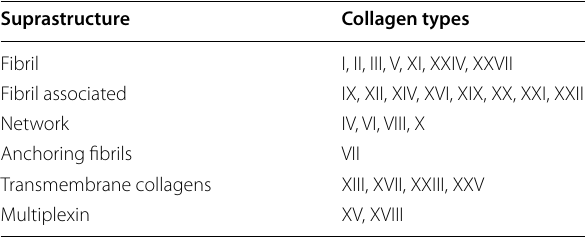
Table 2 Different collagen types organized in various suprastructures. Reproduced with permission from